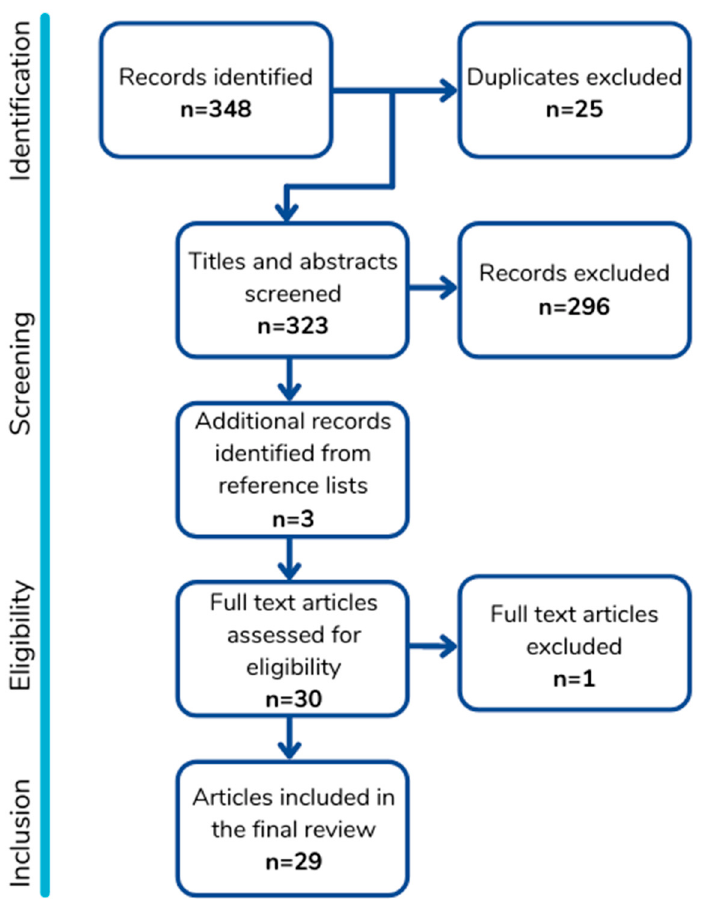
Figure 1. Diagram showing our process of identifying and screening articles for eligibility and inclusion, resulting in the 29 articles included in this metareview.